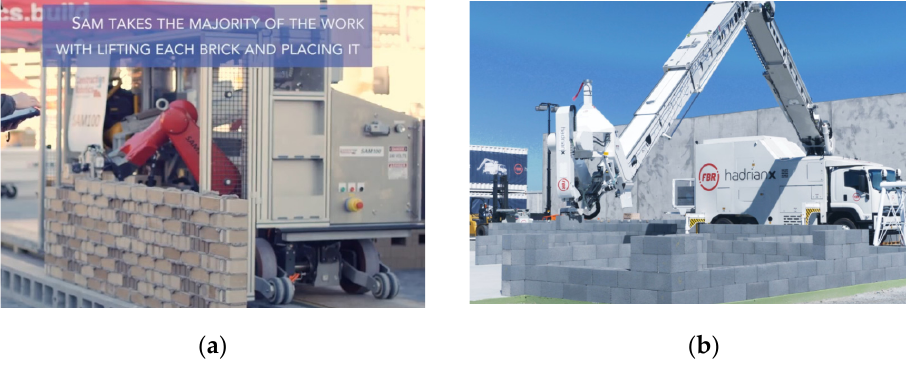
Figure 9. Brick laying robotic systems. ( a ) SAM 100 [140]. ( b ) Hadrian X [141].